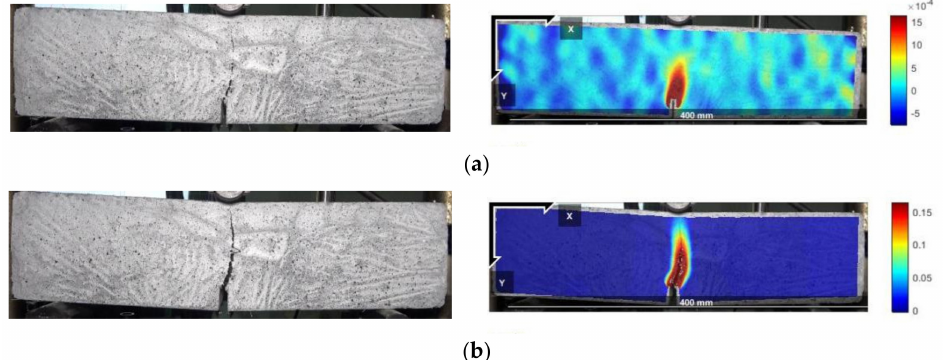
Figure 4. Failure process (left) and DIC strain field (right) of the H 0 S 8 specimen. ( a ) Peak value; ( b ) CMOD = 3.5 mm.